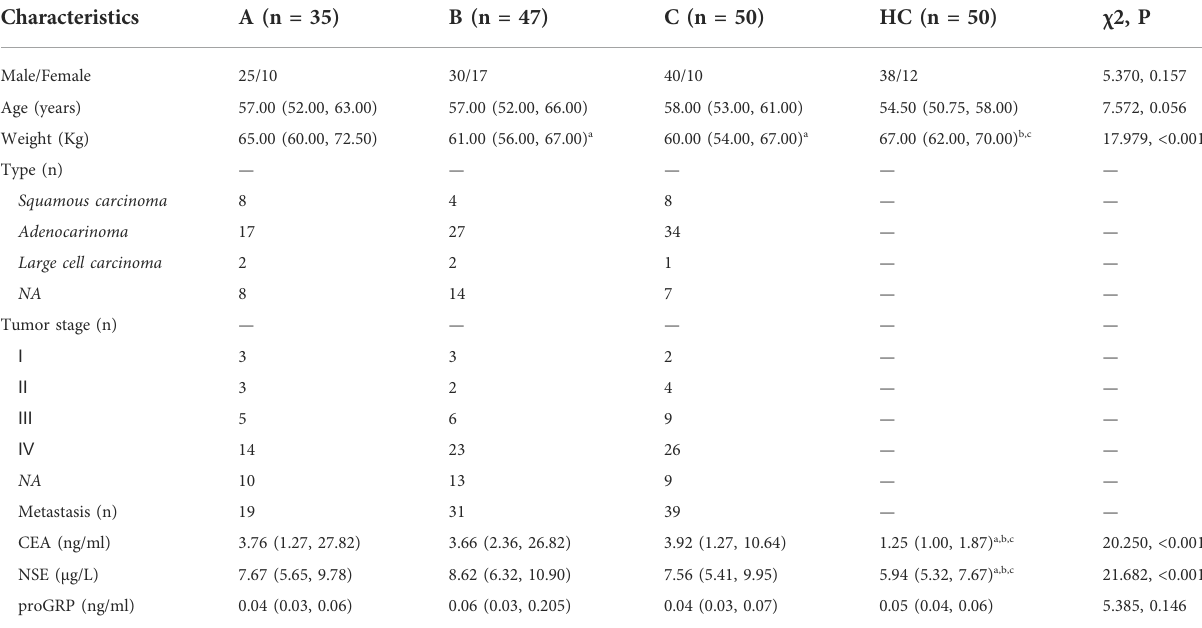
TABLE 1 The clinical characteristics of the enroled participants. Characteristics